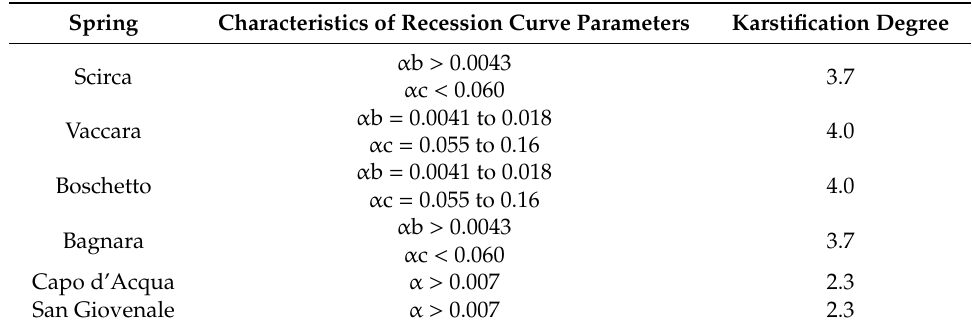
Table 7. Karstification degrees of spring recharge areas according to recession curve parameters, after